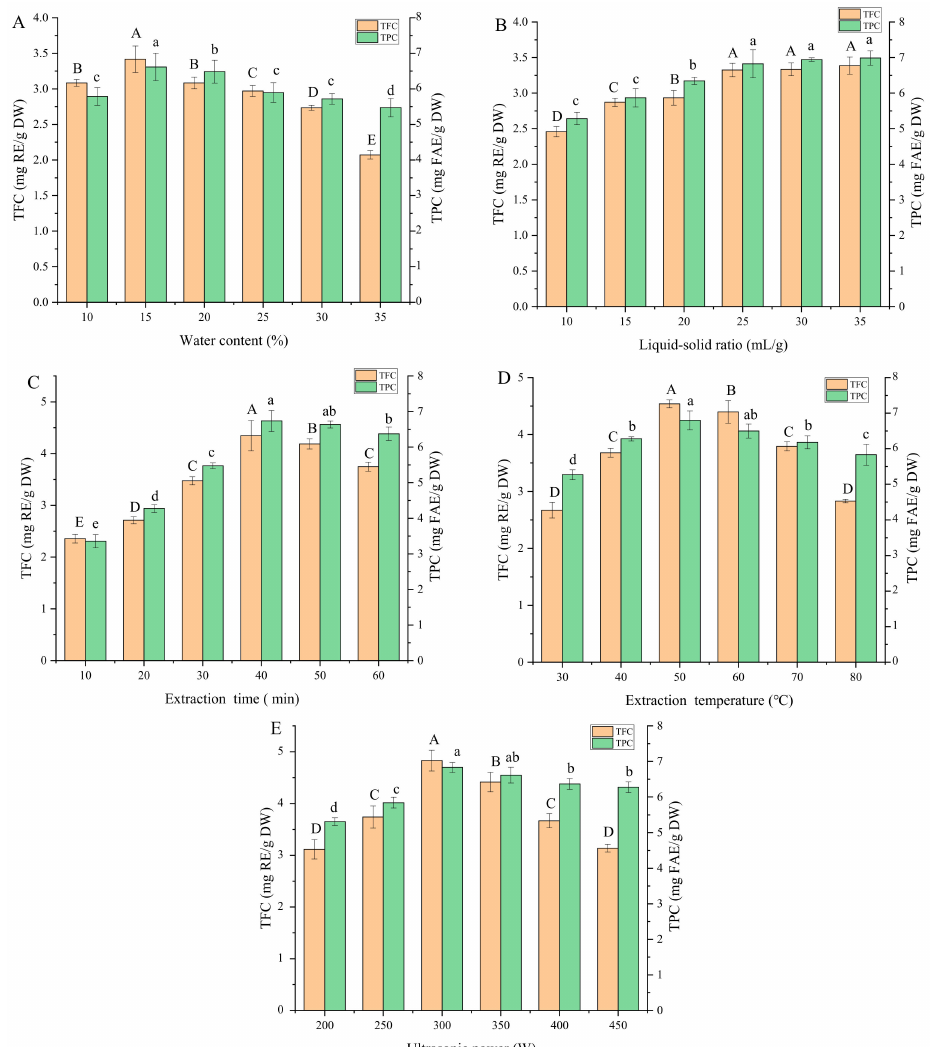
Figure 2. Effects of the investigated extraction variables on TFC and TPC from foxtail millet husk. wa- ter content ( A ), liquid–solid ratio ( B ), extraction time ( C ), extraction temperature ( D ), and ultrasonic power ( E ). Different lowercase letters or uppercase letters indicate significant differences ( p <